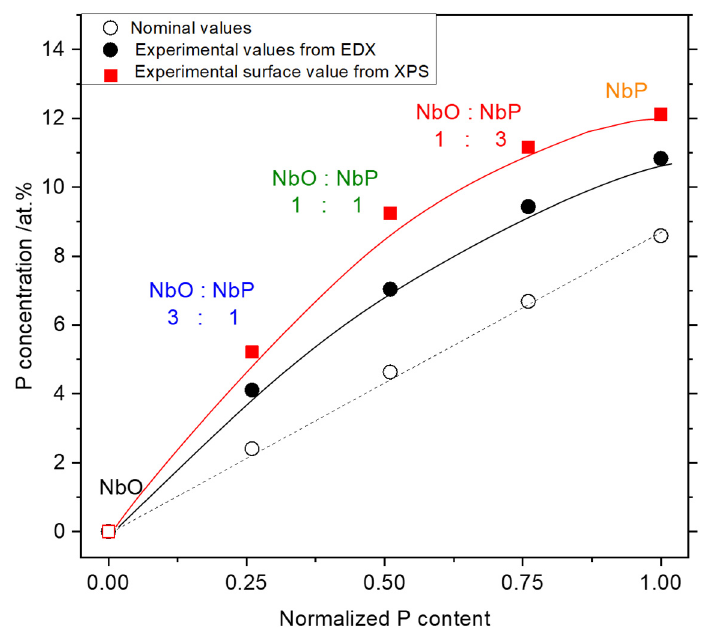
Figure 1. Phosphorous concentration of the NbO and NbP samples and relevant physical mixtures as a function of normalized P content (calculated assuming unit value, p = 1, for NbP). Nominal values refer to the expected composition based on the weighed amount of NbO and NbP in the NbO:NbP mixtures and sample compositions as indicated in Table 1.